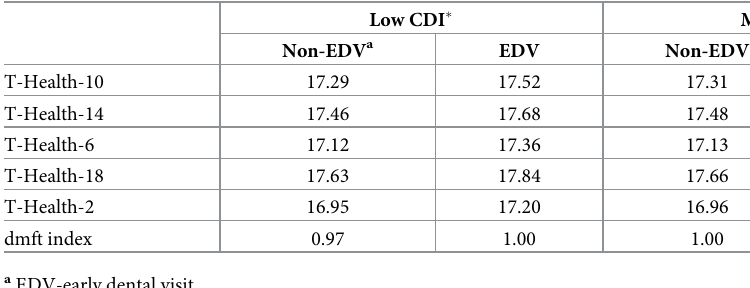
Table 2. Effectiveness according to composite deprivation index.